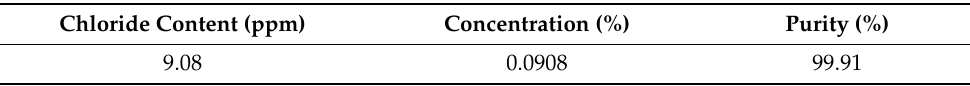
Table 1. Chloride content and the purity of the newly synthesized [MTMSPI][TS] ionic liquid.